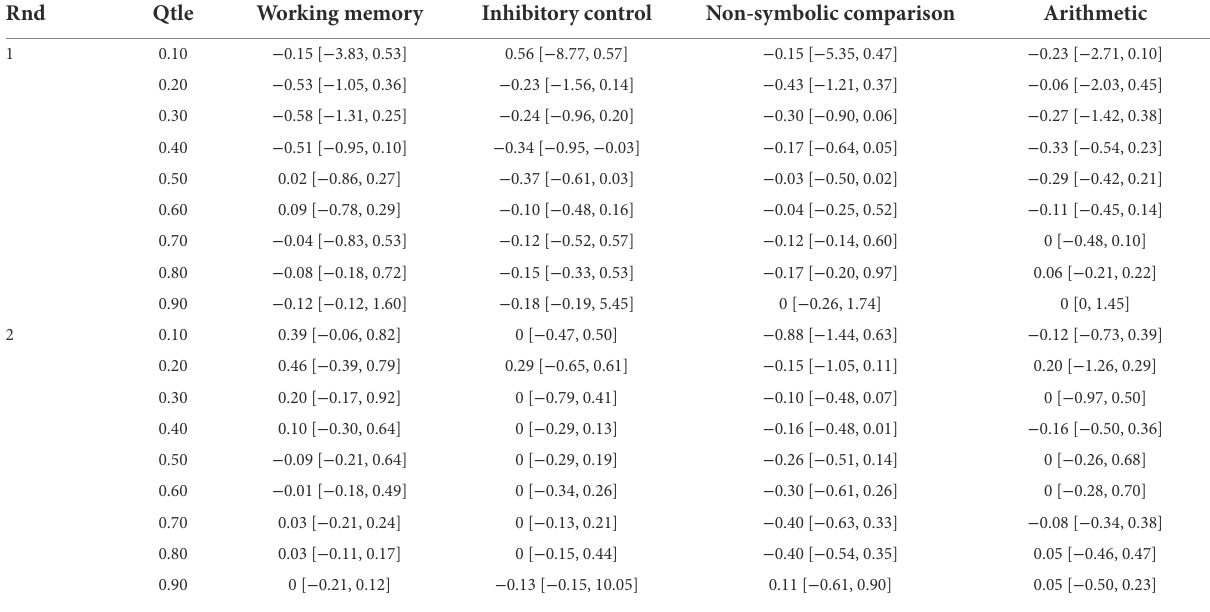
TABLE 4 Quantile regression coefficient estimates and 95% confidence intervals with exposure as